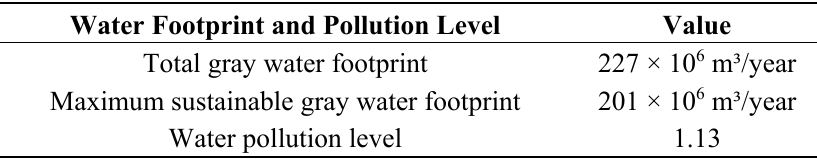
Table 4. Water pollution level in